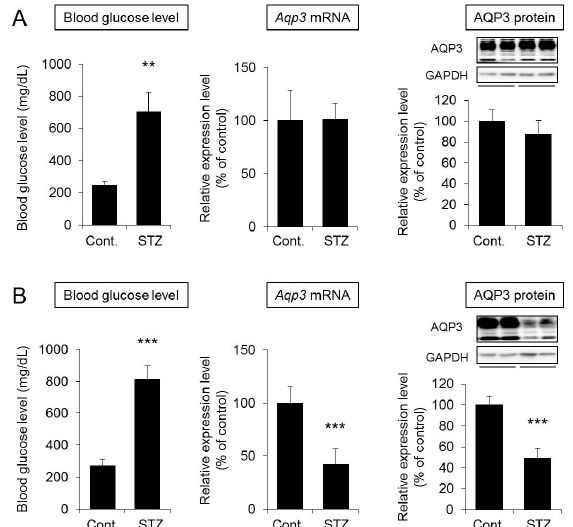
Figure 4. Relationship between the blood glucose level and skin AQP3 level. Mice were given a single intravenous administration of STZ. After one week ( A ) or two weeks ( B ), blood glucose levels were measured. The Aqp3 mRNA expression level in the skin was analyzed by real-time RT-PCR. After normalization with 18S rRNA , the data are presented with the mean value of the control group set at 100%. The protein expression of AQP3 in the skin was analyzed by Western blotting. After normalization with GAPDH, the data are shown with the mean value of the control group set at 100% (mean ± SD, n = 5; ** p < 0.01 and *** p < 0.001).